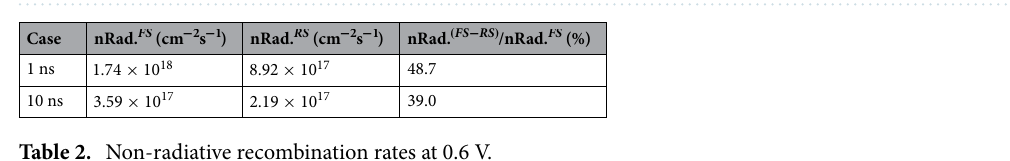
Figure 6. ( a ) HI vs. scan rate for carrier lifetimes of 1, 5, and 10 ns. ( b ) J – V characteristics for carrier lifetimes of 20, 70, and 200 ns. ( c , d ) Conduction band and carrier density for carrier lifetimes of 20 and 200 ns at 0.6 V for the forward and reverse scanning, respectively. ( e , f ) Net ion density distribution and non-radiative recombination rate, respectively, for the two cases at a voltage of 0.6 V for the forward and reverse scanning.